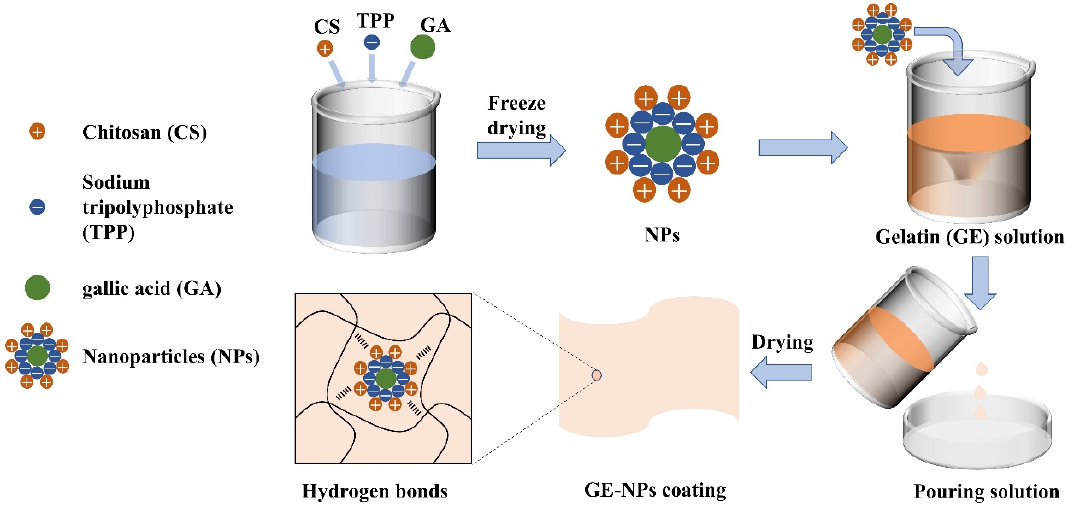
Figure 1. Schematic diagram of the preparation of GE nanocomposite